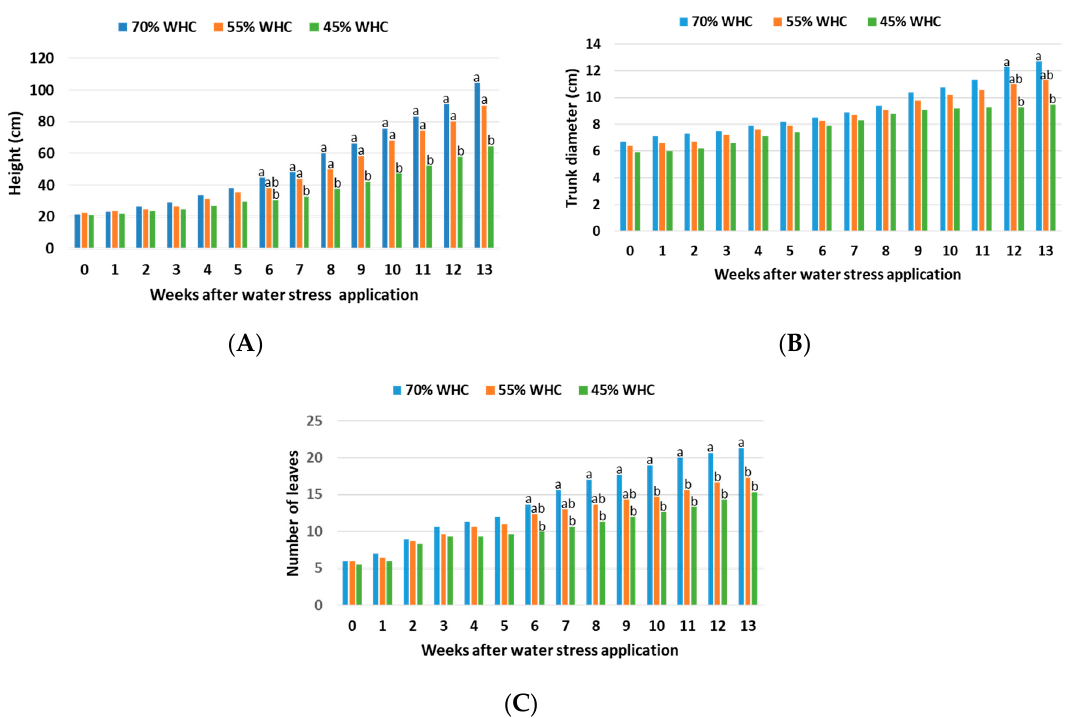
Figure 1. Effect of water stress on plant growth parameters: ( A ) height, ( B ) diameter, ( C ) number of leaves (ANOVA, Duncan test, p < 0.05, n = 5).